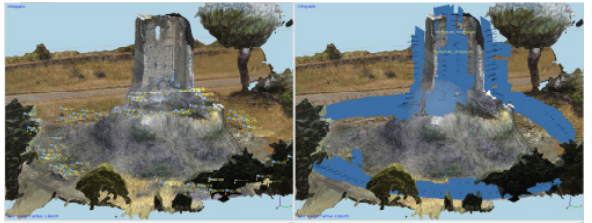
Figure 8. GPS and coded targets (left), shooting complex